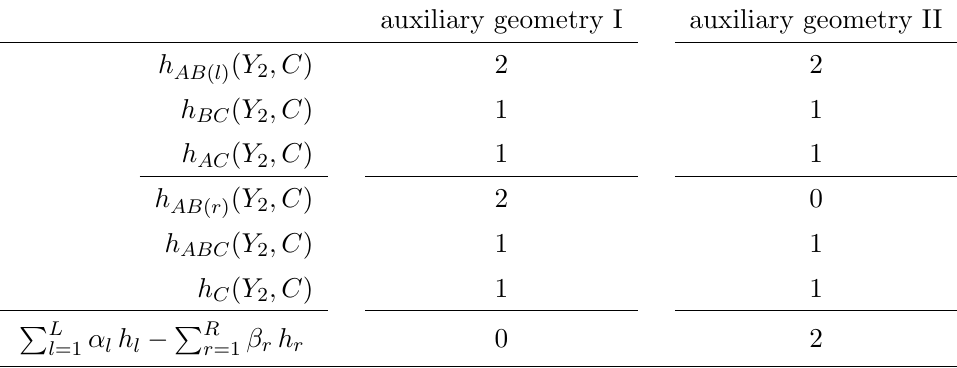
Table 4 . The quantities h l ( Y 2 ; C ) and h r ( Y 2 ; C ) derived from using either auxiliary